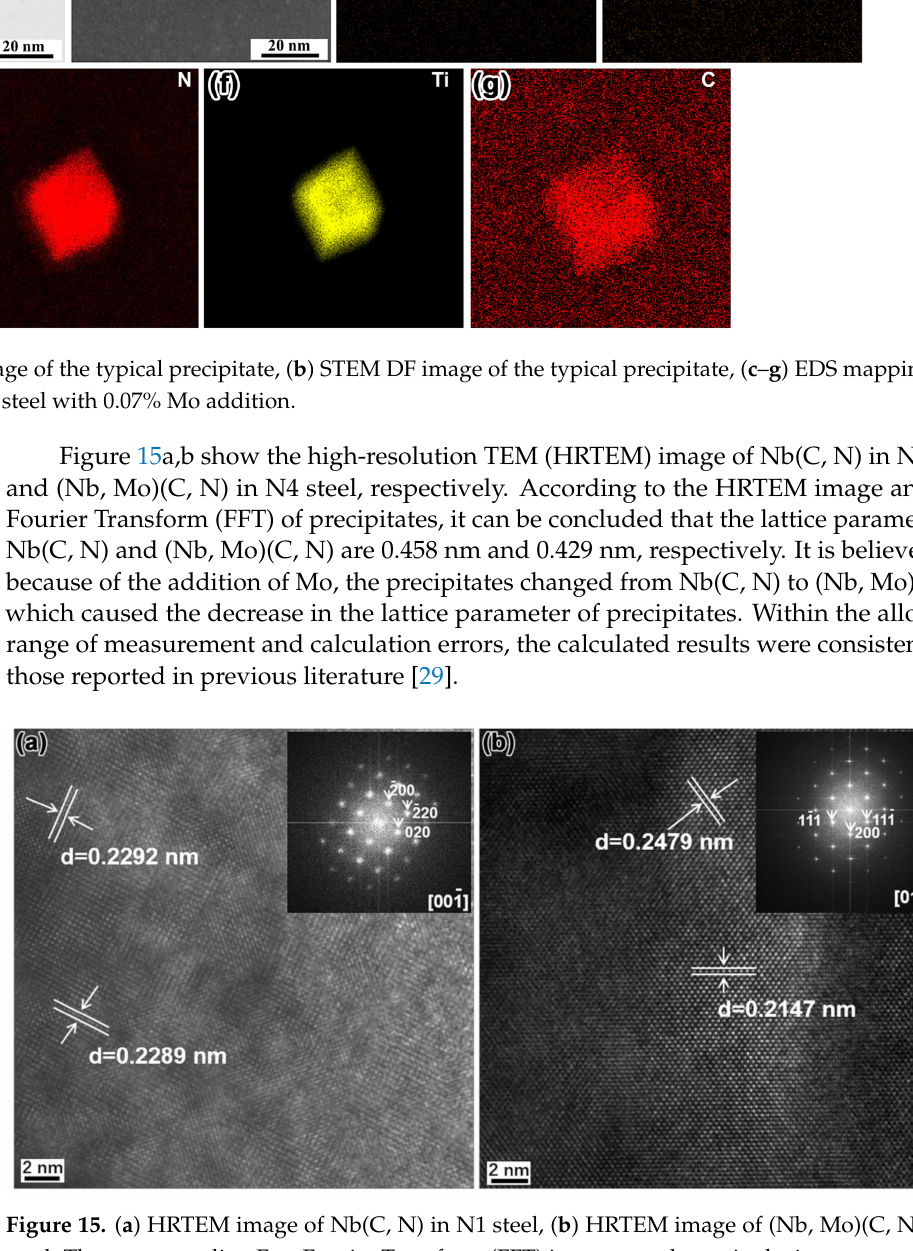
Figure 13. ( a ) STEM bright-field (BF) image of the typical precipitate, ( b ) STEM dark-field (DF) image of the typical pre-